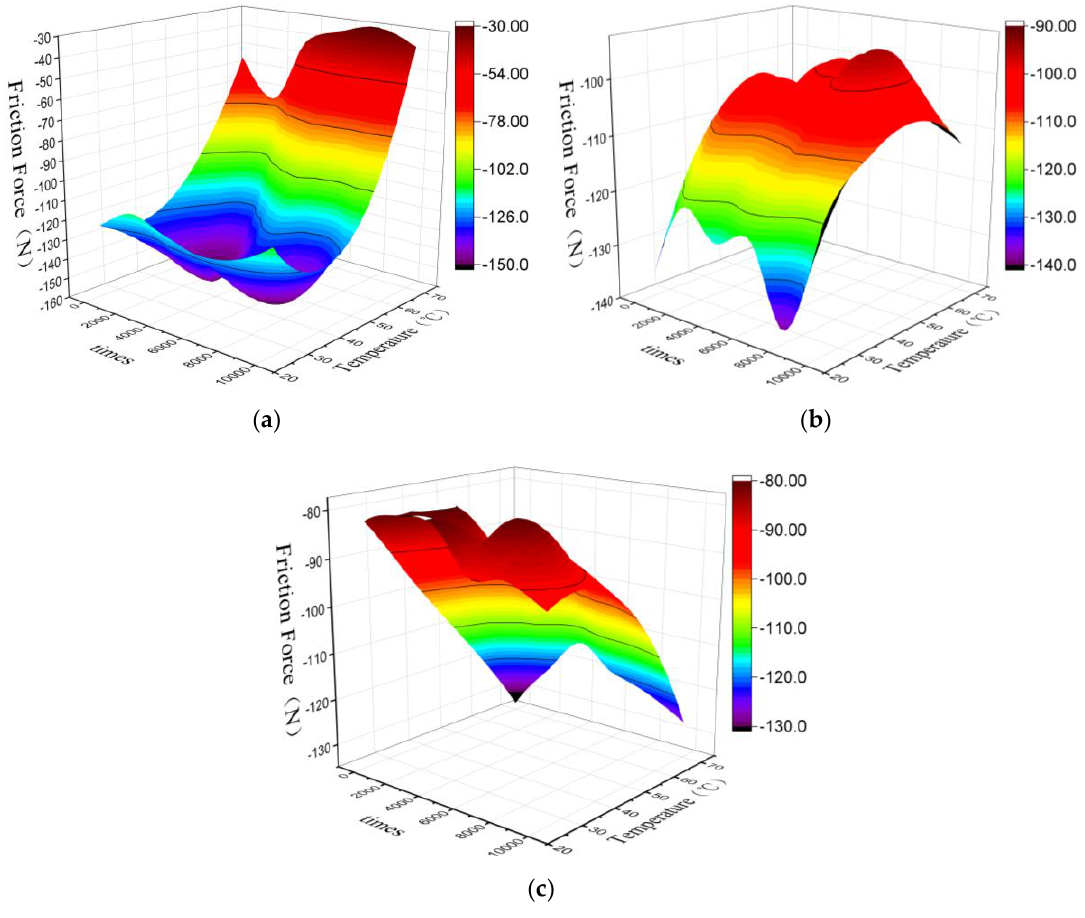
Figure 8. At different relative speeds between cables, the ambient temperature with the Figure 8. At di ff erent relative speeds between cables, the ambient temperature with the corresponding corresponding friction force between the cables; ( a ) 5 mm/s, ( b ) 7.5 mm/s, ( c ) 10 mm/s. friction force between the cables; ( a ) 5 mm / s, ( b ) 7.5 mm / s, ( c ) 10 mm /